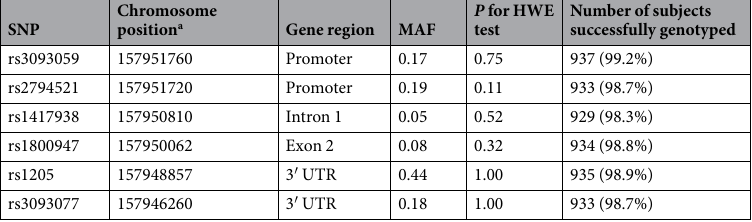
1.00 933 (98.7%) Table 2. CRP single-nucleotide polymorphisms (SNPs) genotyped in the SAPPHIRe study. MAF, minor allele frequency; HWE, Hardy-Weinberg equilibrium. a Build 36.3.